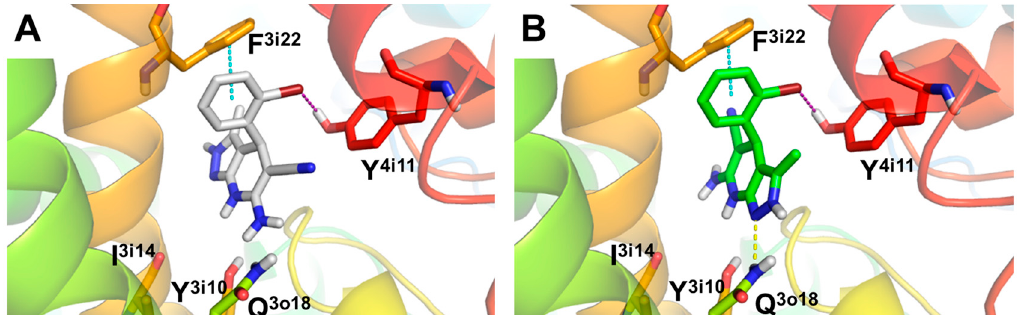
Figure 2. Molecular docking of compound 4f (Ar = 2-BrPh), ( R )- and ( S )- enantiomers, at the 1,4-DHP binding site of Ca V 1.2 L -type VDCC. ( A ) Predicted binding mode for 4f ( R )-enantiomer and ( B ) ( S )-enantiomer represented as white and green sticks, respectively. Hydrogen bond, halogen bond and π - π stacking interactions showed as yellow, purple and blue dotted lines, respectively. Ca V 1.2 L-type channel structure represented as colored cartoon with key residues as sticks.